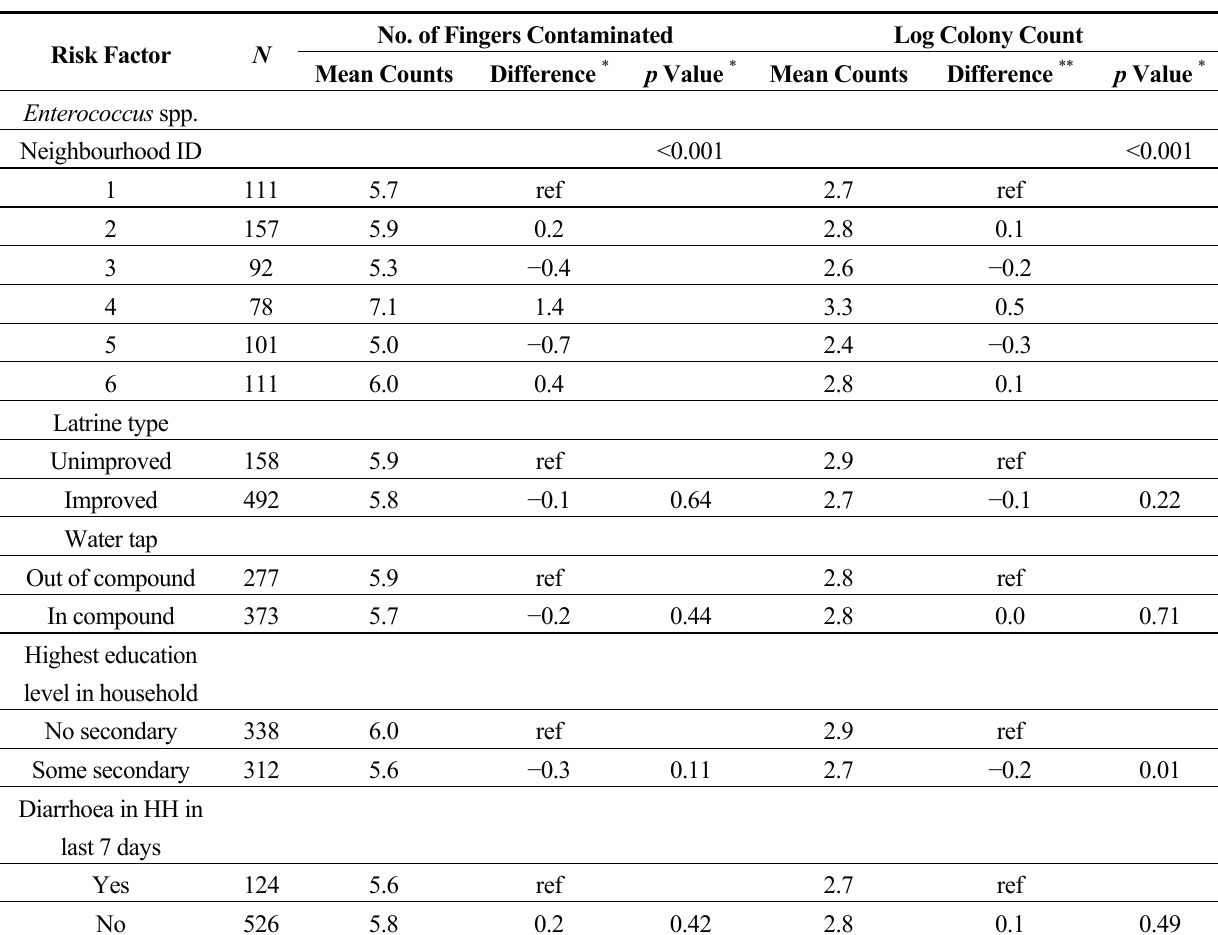
Table 3. Cross sectional study Mozambique: Effect of household characteristics on the mean number of fingers contaminated and mean log colony count of Enterococcus and E. coli ( N = 650). No. of Fingers Contaminated Log Colony Count N Mean Counts Difference * p Value * Mean Counts Difference ** p Value